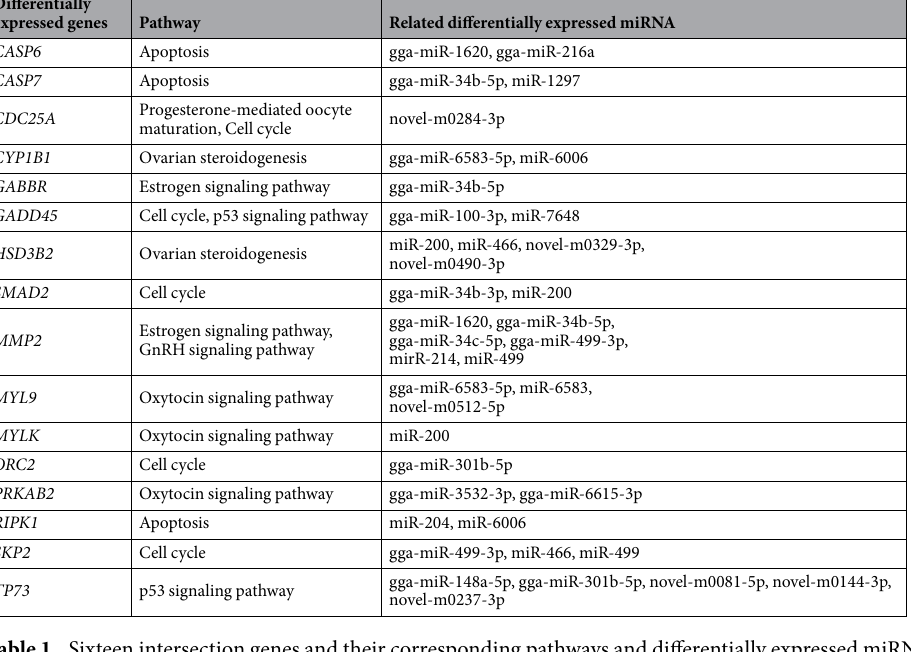
Construction of competing endogenous RNA (ceRNA) network. Based on the data for dif- ferentially expressed protein-coding transcripts, miRNA, and lncRNA transcripts, we used three softwares RNAhybrid(v2.1.2) + svm_light(v6.01), Miranda(v3.3a) and TargetScan(Version:7.0) to identify biological targets of each miRNA from the protein-coding and lncRNA transcripts that showed a significantly negative correlation with miRNA expression, subsequently obtained the protein-coding transcript -miRNA and lncRNA transcript-miRNA pairs, then constructed the competing endogenous RNA (ceRNA) network (Fig. 7), which